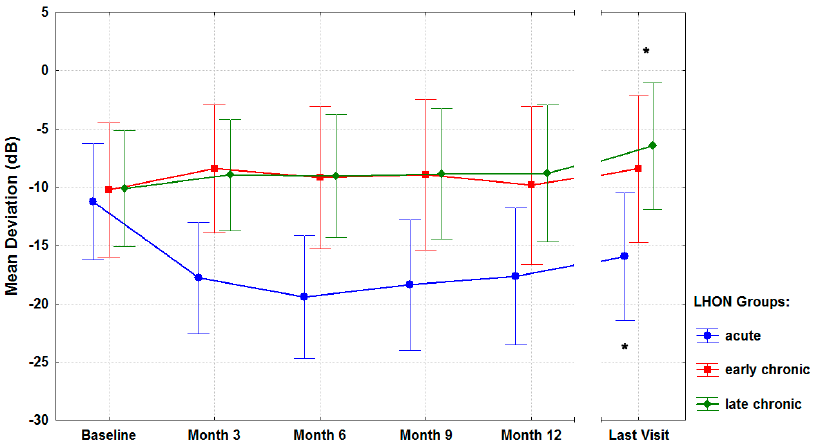
Figure 3. Visual field mean deviation over time in the different groups of LHON patients treated with idebenone. Time from LHON onset at treatment initiation was <1 year in acute patients, 1–5 years in early chronic patients and >5 years in late chronic patients. Data are presented as least square means and 0.95 confidence intervals. * Statistically significant change from nadir or baseline in acute and chronic groups, respectively ( p < 0.05, Wilkoxon signed-rank test).